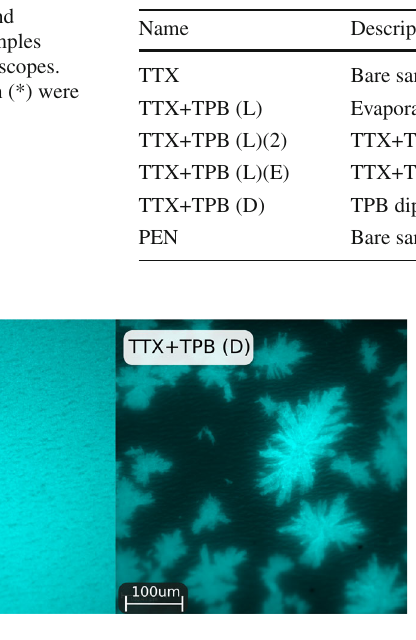
Fig. 18 Fluorescence microscopy images of TTX+TPB (L) and TTX+TPB (dip-coated). The scale bars are 100 µ m